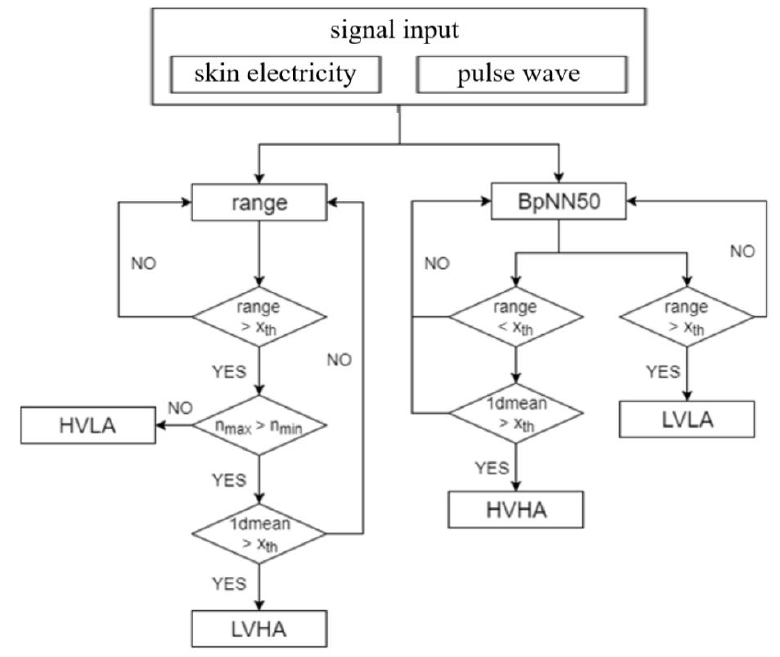
Figure 12. Process of model of emotion